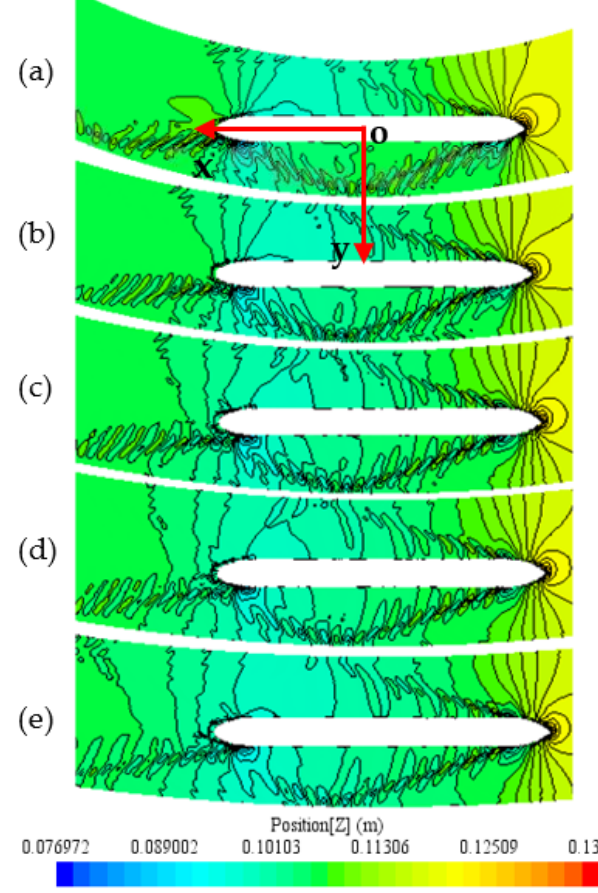
Figure 9. Free surface elevation contour of channel radius variation. ( a – e ): Channel radius from 12.52 m to 34.84 m.